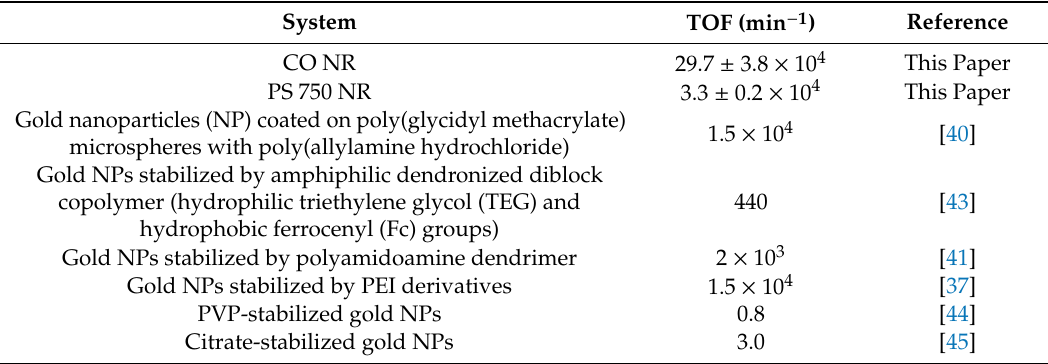
Table 6. Turnover frequencies (TOF) of nanoreactors compared to other hybrid nanoparticle